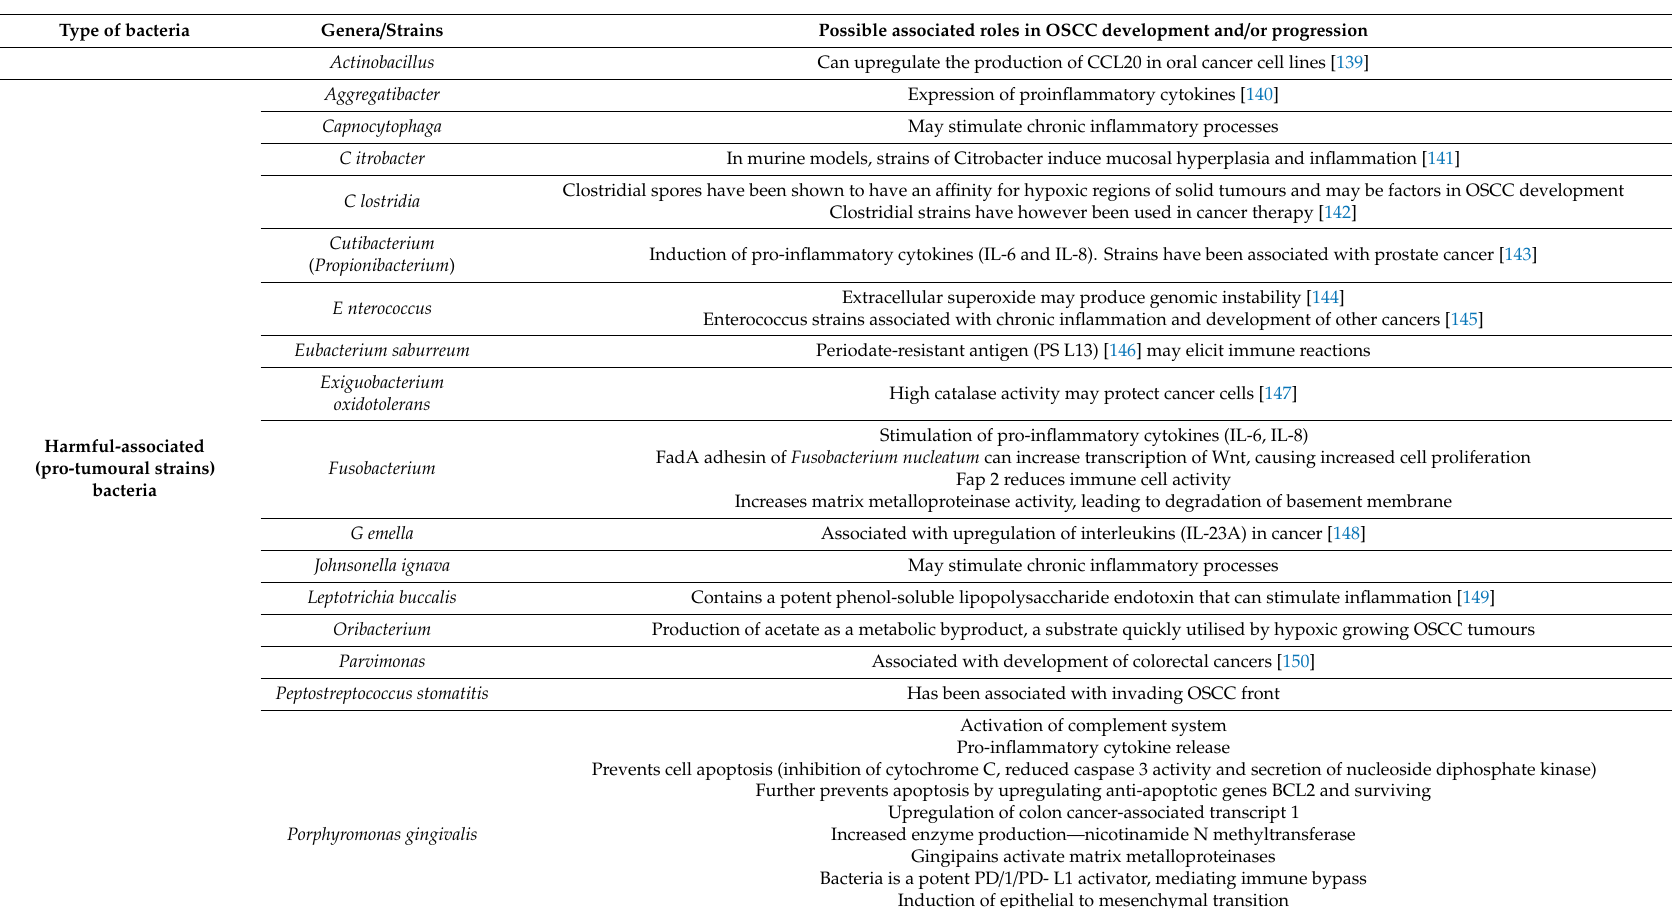
Table 1. Summary of possible associations of harmful and protective bacterial genera and strains and their association with OSCC development and progression. Type of